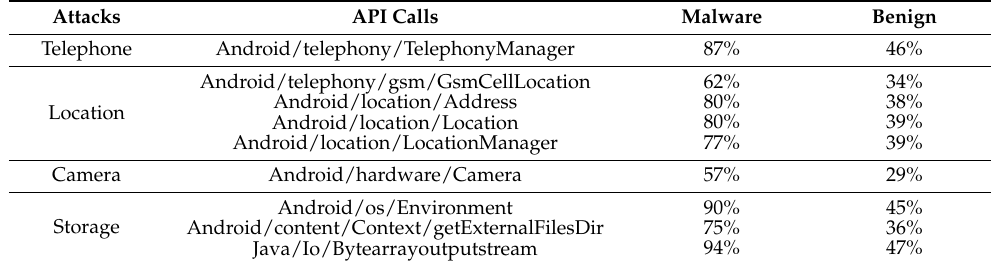
Table 7. Percentage of common API calls by attack type in malicious and benign applications.